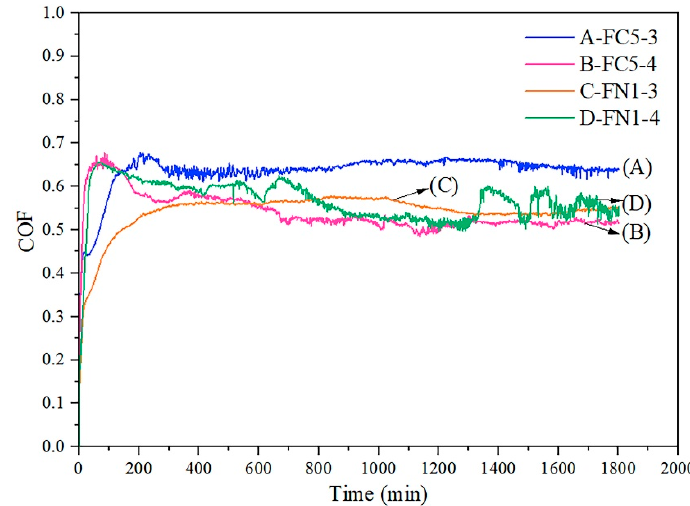
Figure 9. Friction coefficient curves of four coated carbides.